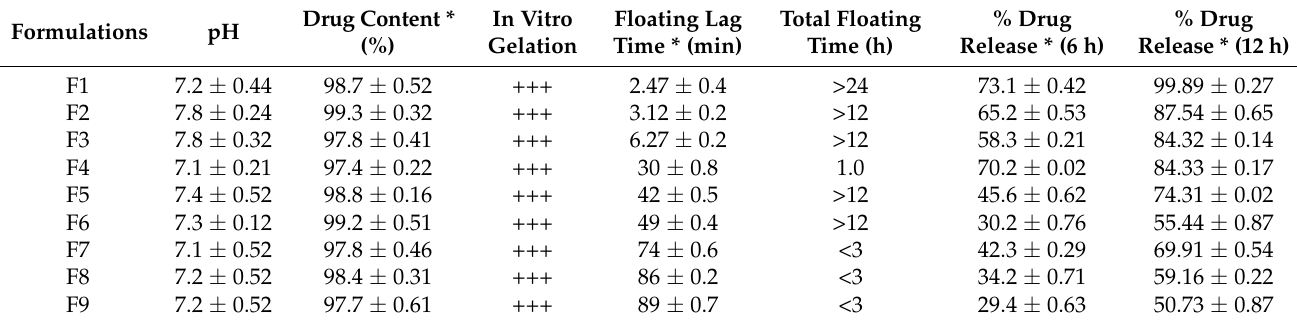
Table 4. Evaluation parameters of the oral raft-forming in situ gelling system of